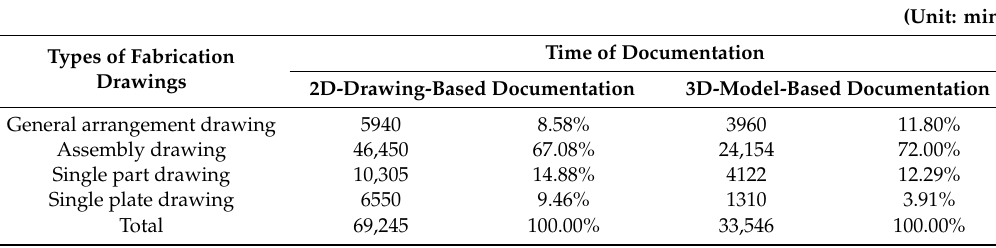
Table 3. Time of documentation comparison of two documentation